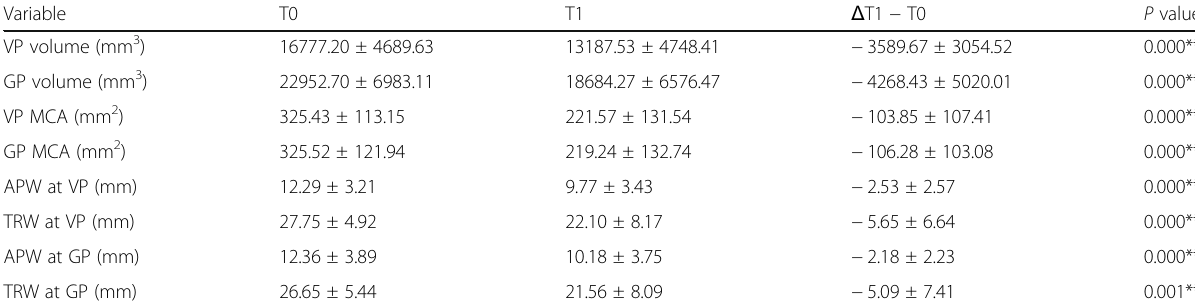
Table 5 Changes in pharyngeal airway space before (T0) and after (T1) surgery Variable